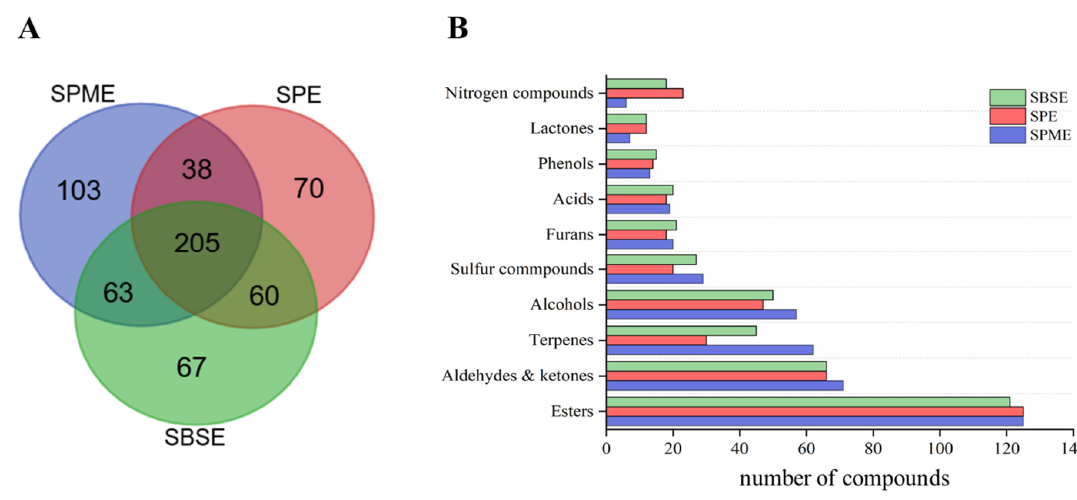
Figure 3. Total ion chromatogram (TIC) contour plot obtained from the HS-SPME-GC×GC-TOFMS, SPE-GC×GC-TOFMS, and SBSE-GC×GC-TOFMS analysis of herbaceous aroma-type Baijiu, and 4 classes of compounds distributed in contour plot (red balls are nitrogenous compounds, green balls are sulfides, gray balls are terpenes, and blue balls are lactone compounds).